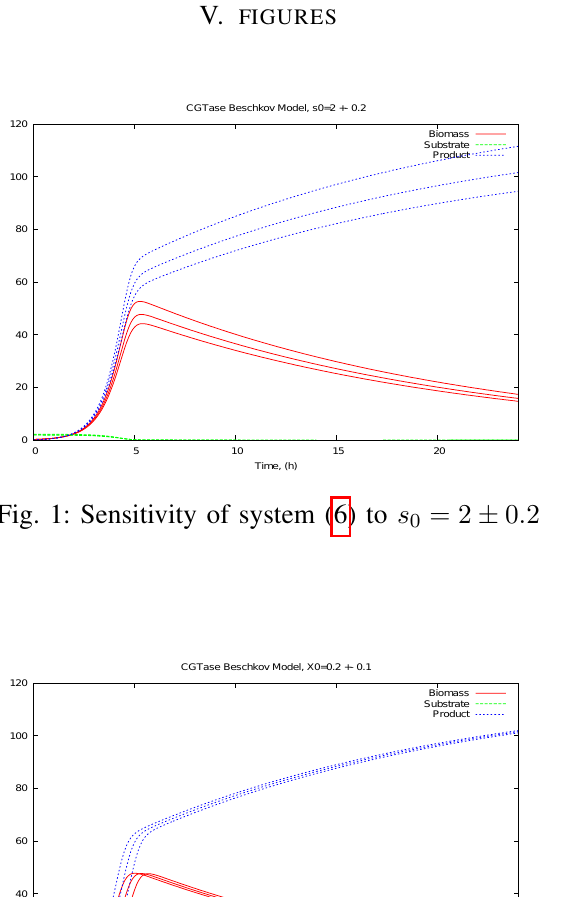
Fig. 5: Solution of system (6) with integrating step h = 0 . 9